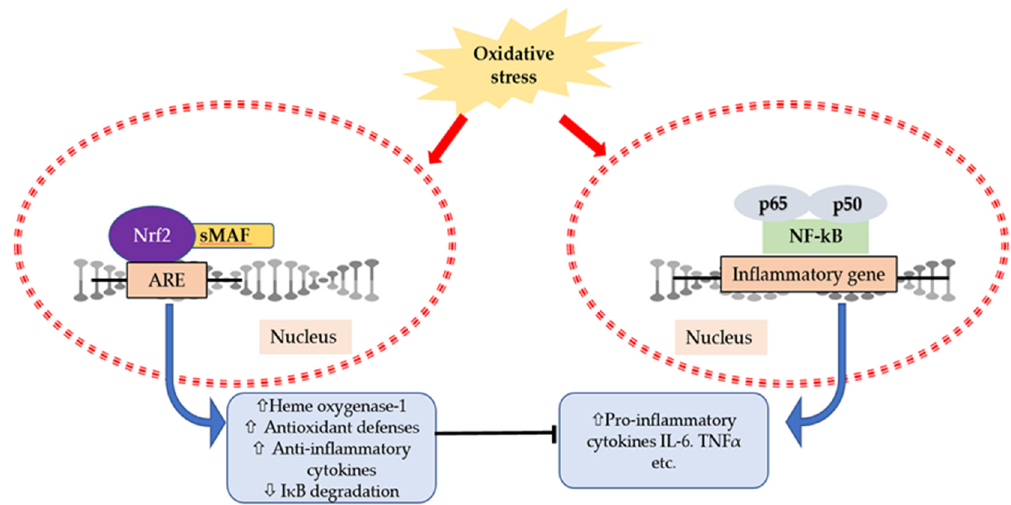
Figure 3. A schematic presentation of interactions between nuclear factor (erythroid-derived 2)-like 2 (Nrf2) and nuclear factor-kappa B (NF- κ B) transcription factors. Under stressed conditions, Nrf2